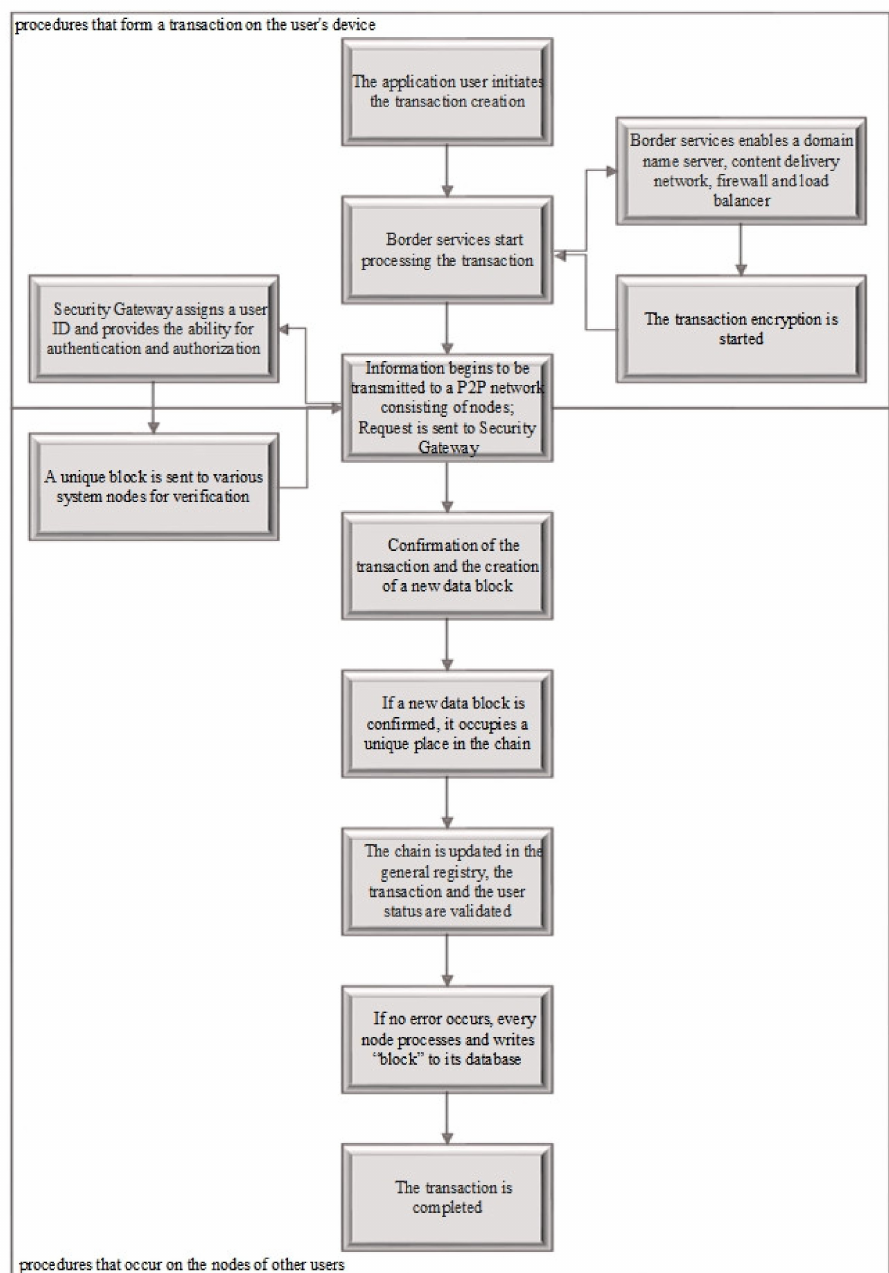
Figure 2. The algorithm of a blockchain technology operation with